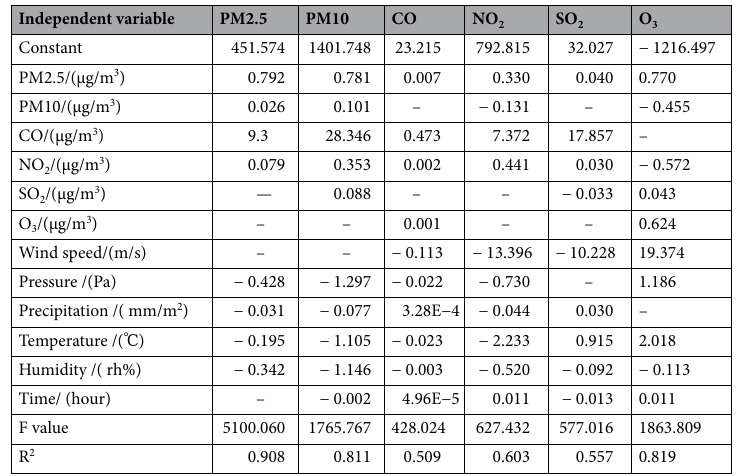
Table 3. Stepwise regression model and model test of six types of air pollutant concentrations. In the model, the dependent variable is the concentration of the six pollutants at the national control point, and the independent variable is the variable and time monitored by the self-built point (– represents the variables eliminated in the model).